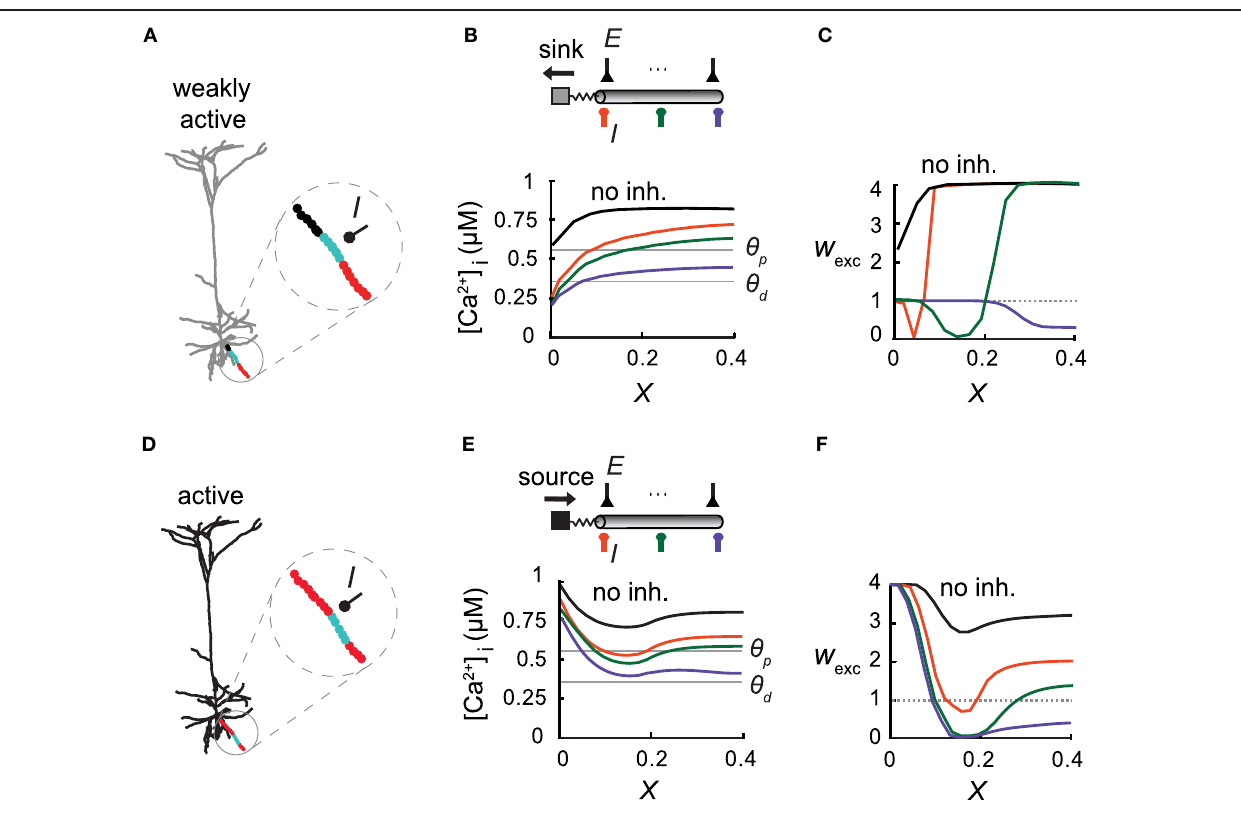
FIGURE 4 | Overall activity level in the modeled cell modifies the inhibitory effect on excitatory plasticity. (A) Model of a L5 Pyramidal cell with low synaptic activity throughout the entire cell (2366 uniformly distributed excitatory synapses, each activated at 1Hz). A basal branch consisting of an inhibitory synapse with a conductance of g inh = 1nS at X = 0 . 5 ( I ) and with multiple excitatory inputs (each activated at 10Hz). The considerable electrical length of this branch and the significant load at the proximal end allowed for the simultaneous occurrence of all three plasticity states (protected—black, depressed—cyan, and potentiated—red) throughout the branch. (B) Top: A simplified model emulating the dendritic branch in (A) . Inhibitory input ( I ) was activated at X = 0 (orange), X = 0 . 07